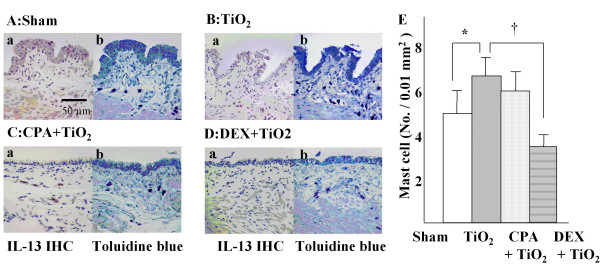
The effects of cyclophosphamide (CPA) or dexamethasone (DEX) on the IL-13 (+) expressing cells. Rats were pretreated intratracheally with saline (Fig. A, E ; n = 8), CPA (Fig. C, E ; n = 6) or DEX (Fig. D, E ; n = 6) prior to treatment with TiO2 Eight rats were treated with TiO2 alone (Fig. B, E ; n = 8) as described in Methods. At 48 h post-treatment, IL-13 (+) cells are stained brown whereas toluidine blue (+) mast cells are stained dark purple. Note that saline – treated group contained little or no IL-13 (+) cells (Aa) in spite of the presence of mast cells (Ab). TiO2-treated group showed significantly increasing numbers of mast cells when compared with sham group (E) and the mast cells (Ba) showed strong positivity for IL-13 protein (Bb). CPA pretreatment did not affect the TiO2 induced-increase in the number of IL-13 (+) cells (Ca) or mast cells (Cb & E). On the other hand, DEX pretreatment significantly decreased the number of mast cells (Db & E) and reduced the IL-13 (+) cells (Da). * p < 0.05 as compared with saline treated group, † p < 0.05 as compared with TiO2 treated group.